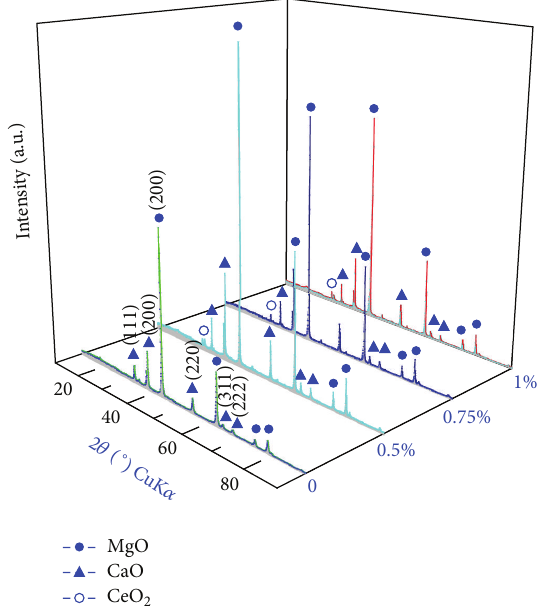
Figure 2: XRD patterns of pure and doped MgO-CaO